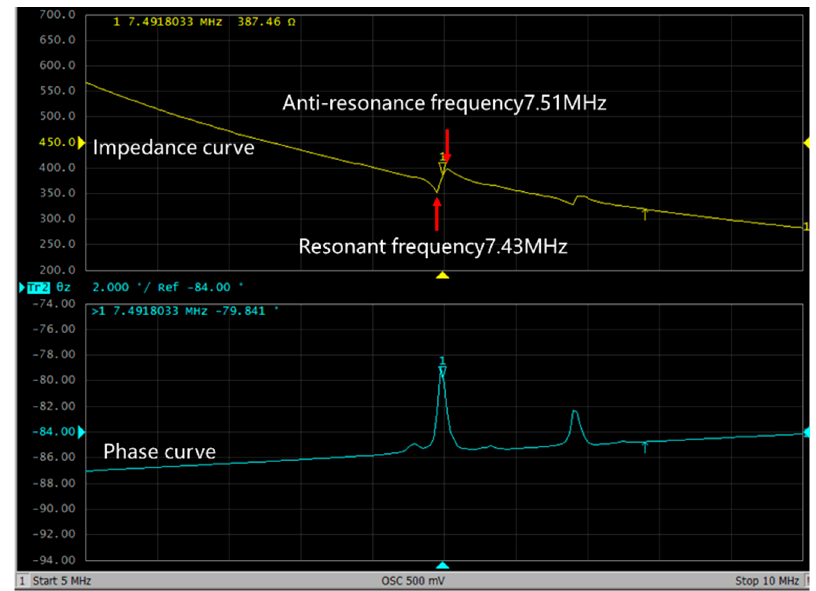
Figure 11. Impedance curve and phase curve of PMUT.